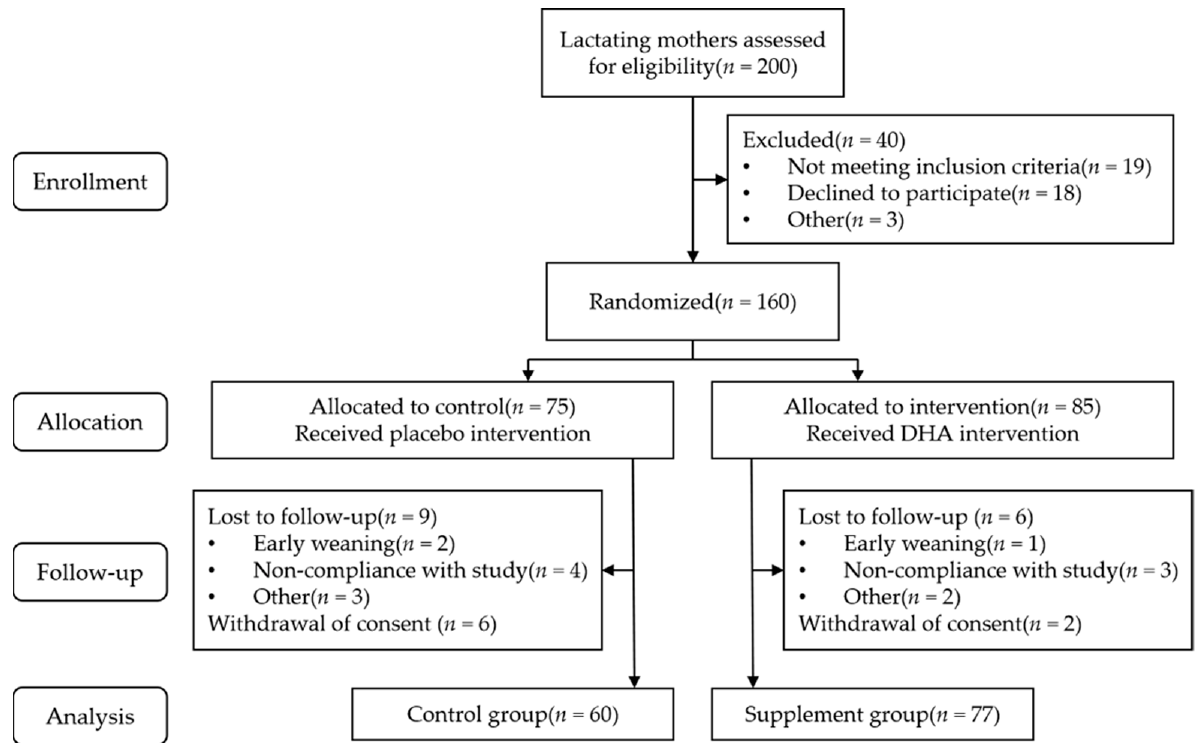
Figure 1. Flow diagram for study subjects. Table 1. Demographic characteristics of the lactating women in this study Characteristics